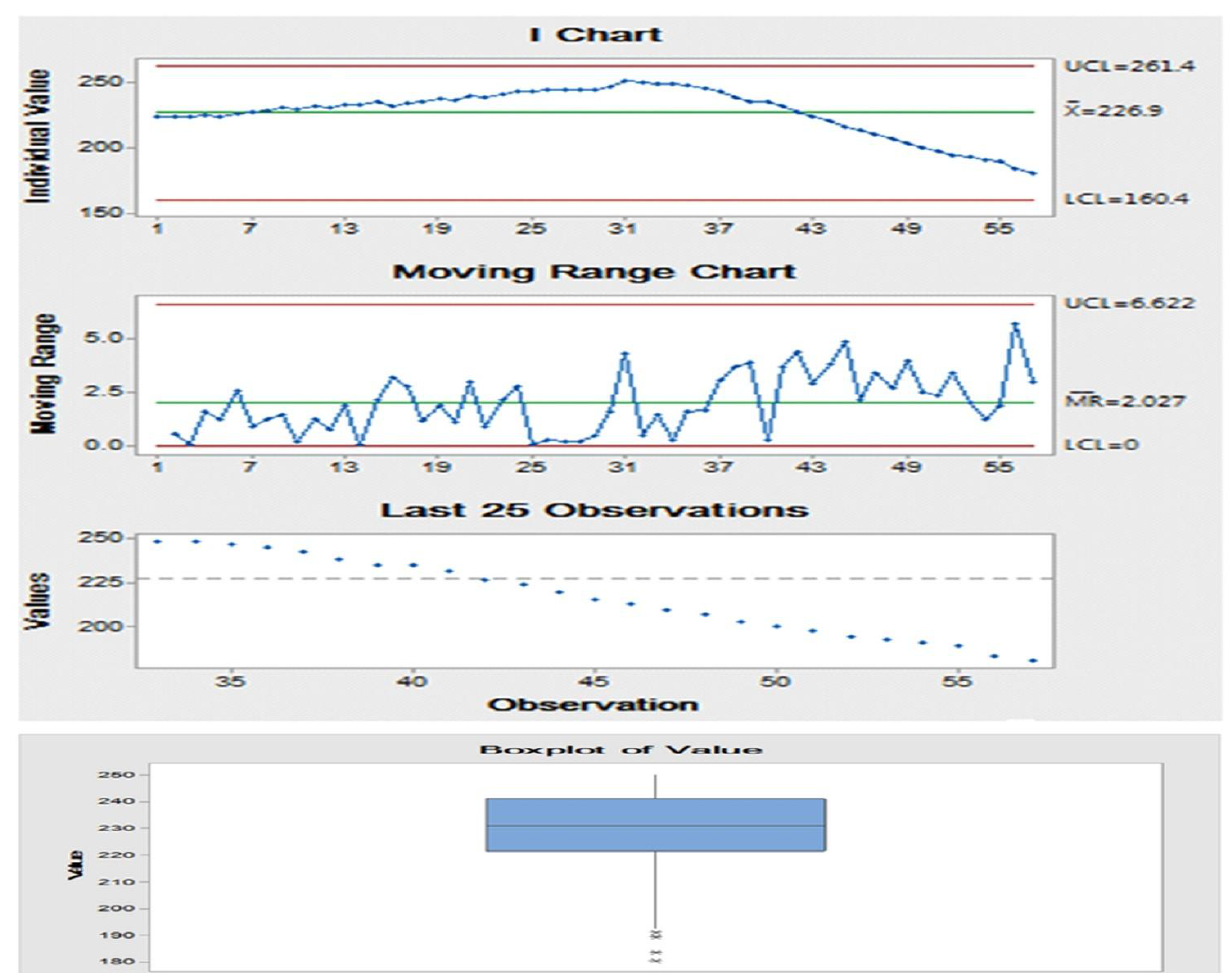
Figure 3: Process-behavior chart of I-MR type showing the overall trend of cancer mortality rates, variability of death rate, the pattern of the latest 25 years period and box plot with exceptionally low rates of cancer